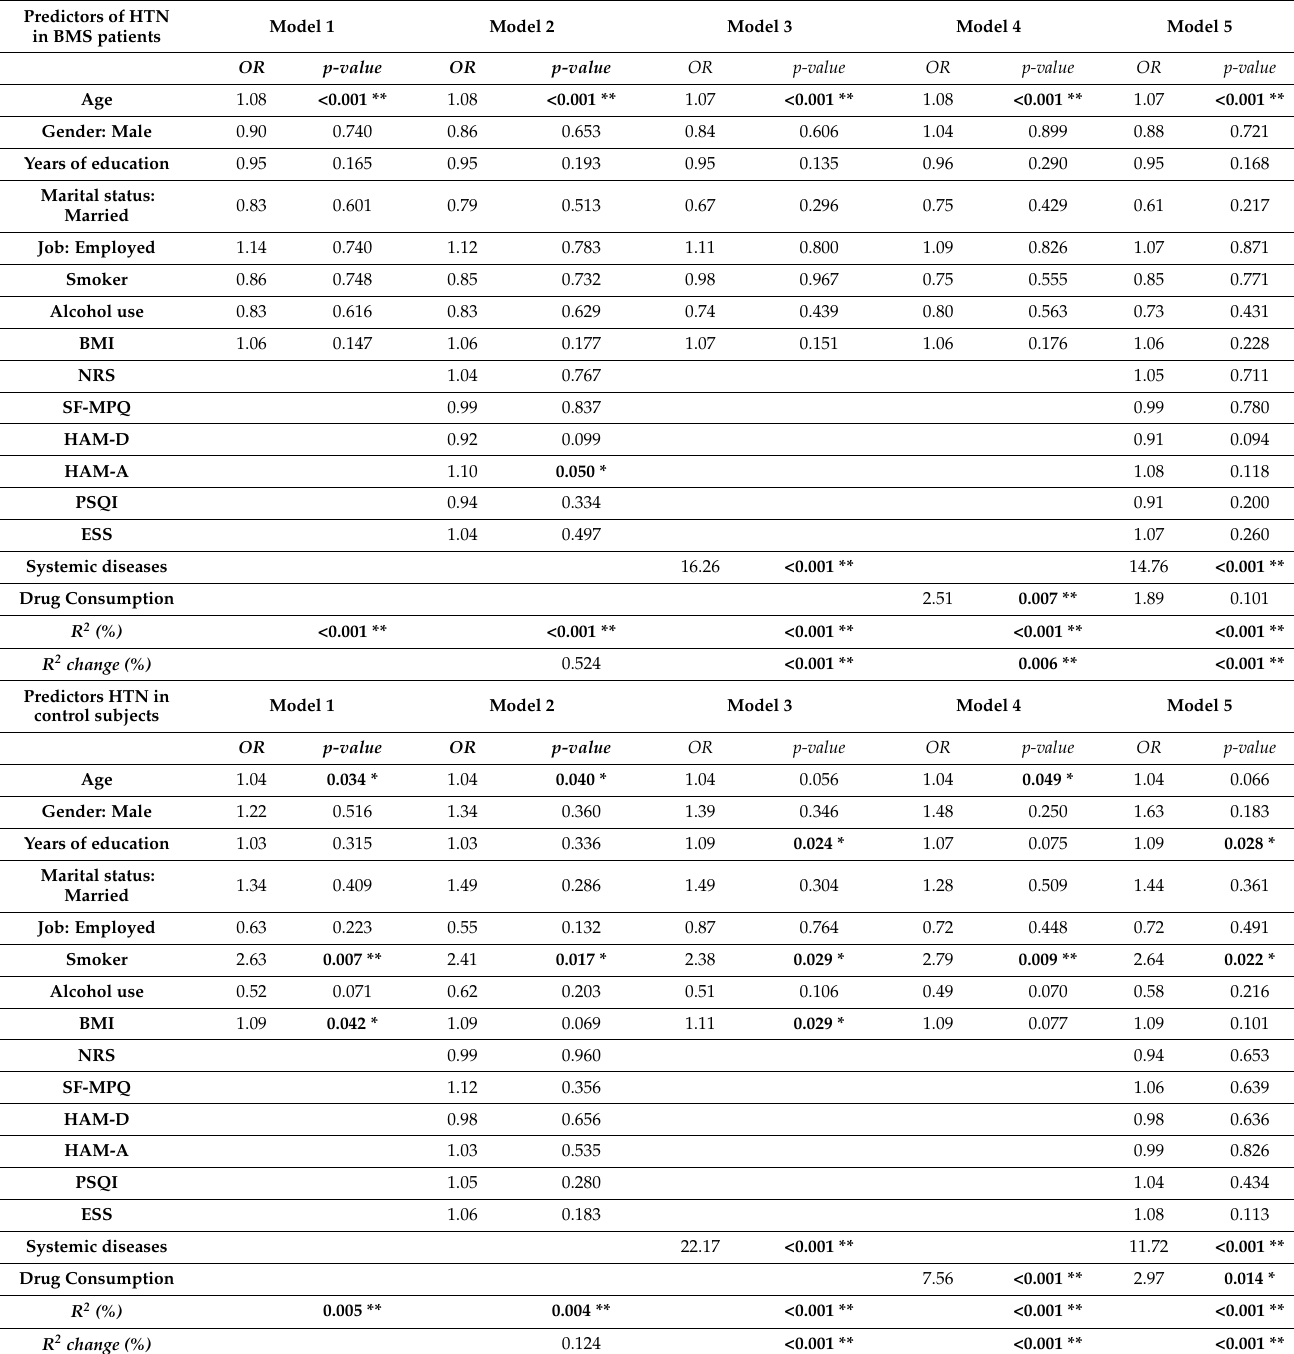
Table 6. Multivariate logistic regression analysis predicting HTN in 242 BMS patients and 242